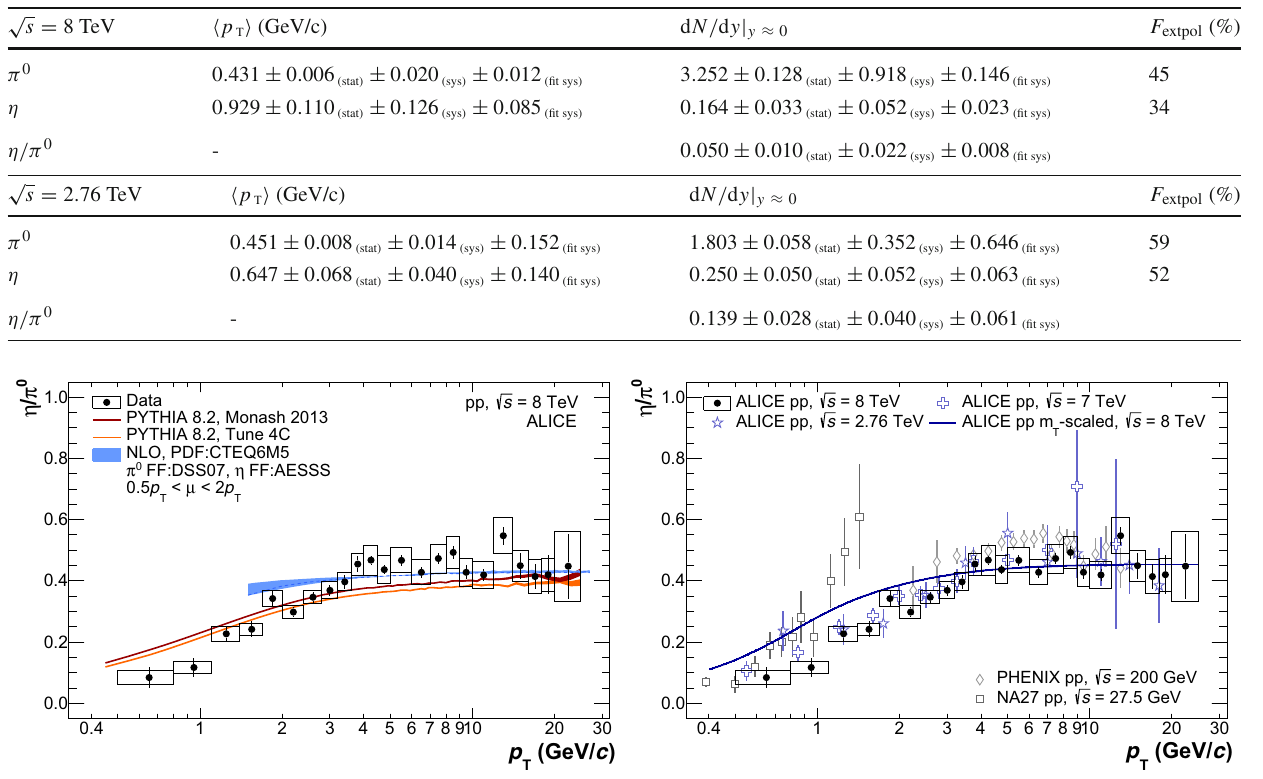
Table 6 The mean transverse momenta, (cid:8) p d N / d y | y ≈ 0 , for ALICE measurements of π 0 and η mesons at 2 . 76 and 8 TeV are summarized [38]. It has to be noted that the uncer- tainties from the measurements of the inelastic cross sections are not